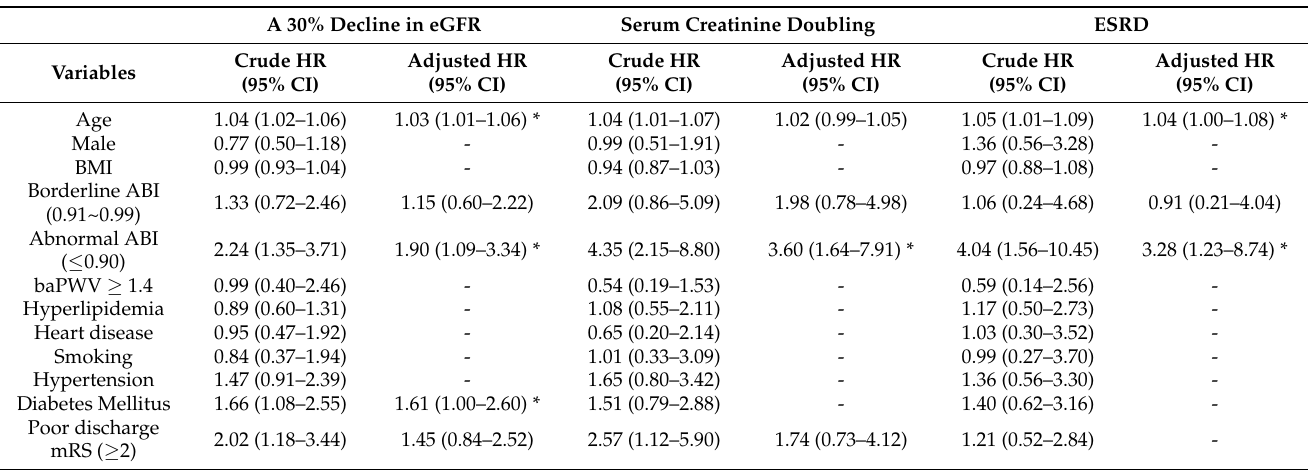
Table 3. Predictors of different renal outcomes during follow-up by the Cox proportional haz- ards model.